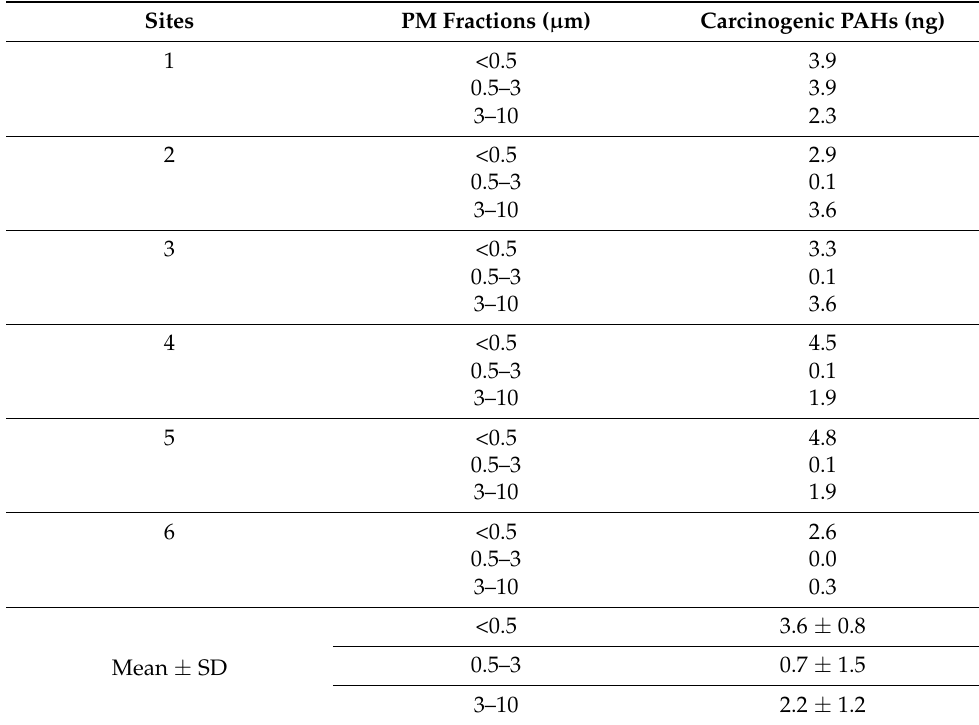
Table 2. Concentrations of PAHs with carcinogenic activity (IARC classification) measured at each sampling site in different fractions of